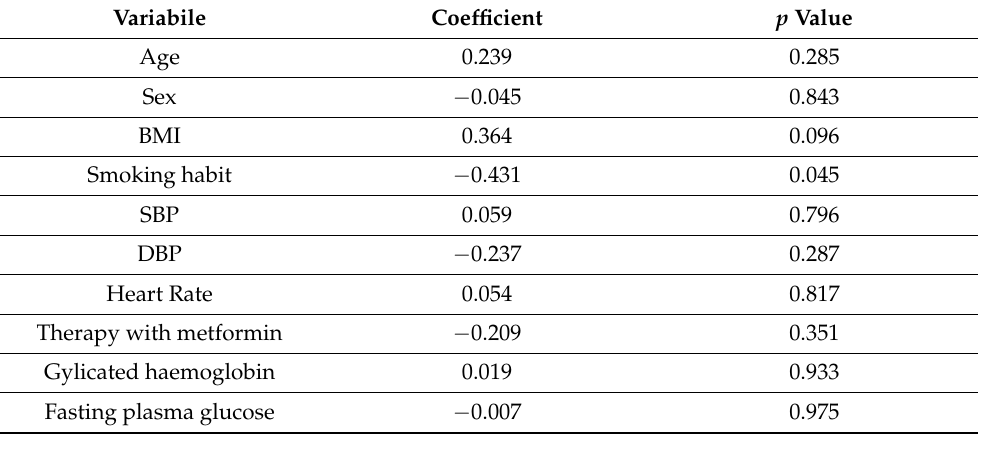
Table 3. Correlations between baseline clinical data and variation of LV GLS after 6-months of treatment. BMI: Body Mass Index; SBP: Systolic Blood Pressure; DBP: Diastolic Blood Pressure.